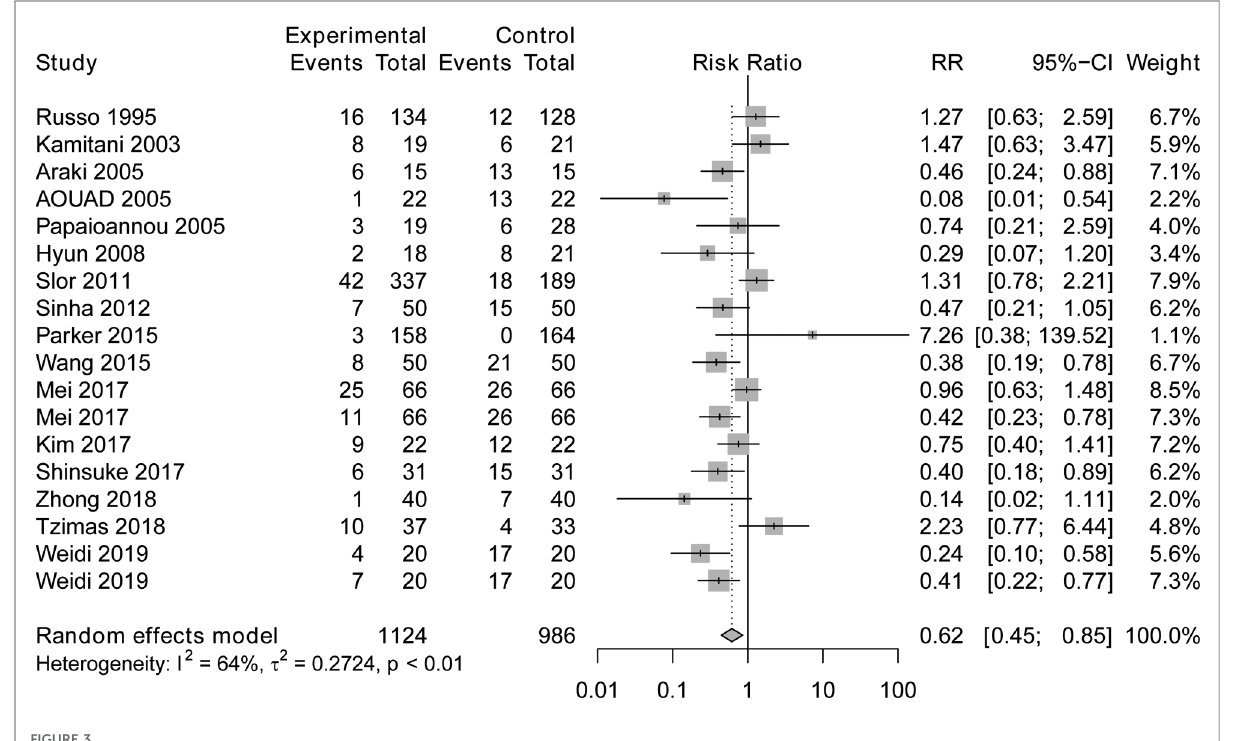
FIGURE 3 Forest plot of regional anesthesia on POD